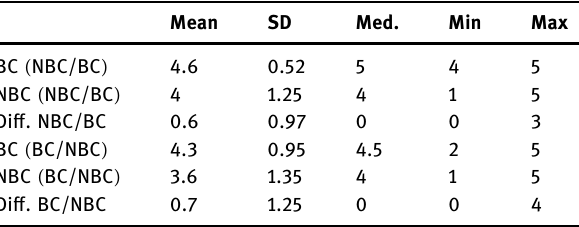
Table 10: Question 12 – Presentation order